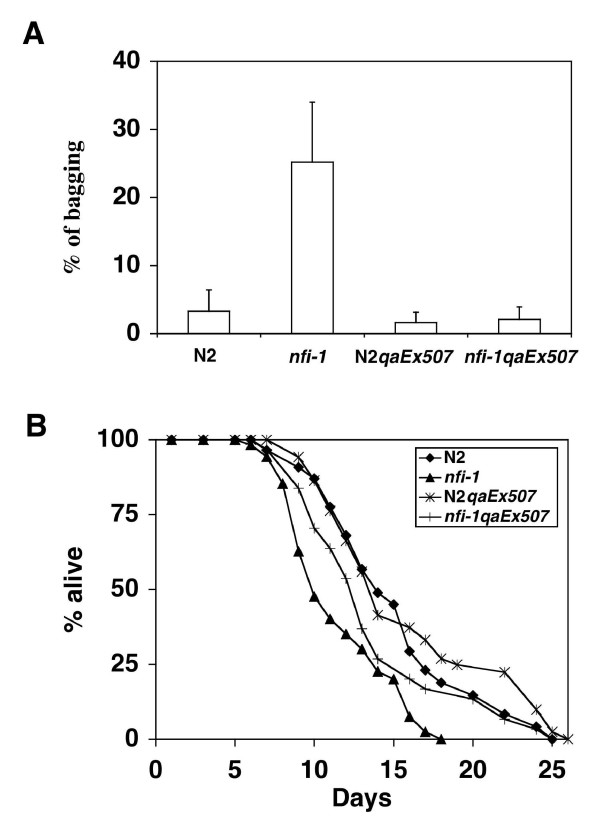
A) Egg-laying defect in nfi-1 mutants and transgenic rescue. Bagging was measured in wild-type N2, nfi-1, N2 worms carrying the transgenic array qaEx507(N2 qaEx507) and nfi-1 worms carrying this array (nfi-1 qaEx507). Bars represent % of bagging as the mean of 3–4 independent experiments and error bars show the standard deviation. 30–75 worms of each genotype were scored in each independent experiment. N2 and N2 qaEx507showed <5% bagging. The nfi-1 mutant worms showed ~30% bagging while the rescued nfi-1 qaEx507showed <5% bagging. B) Shortened life span in nfi-1 mutants and transgenic rescue. Survival curves for the strains described above N2 (n = 57), nfi-1 (n = 58), N2 qaEx507 (n = 52) and nfi-1 qaEx507 (n = 31) are shown. Kaplan-Meier analysis (SPSS11 software) was use to determine median, percentile and p values (log rank test) and Excel was used to construct survival curves. The array generated ~50% rescue of the life-span. The experiment was repeated twice with similar results.